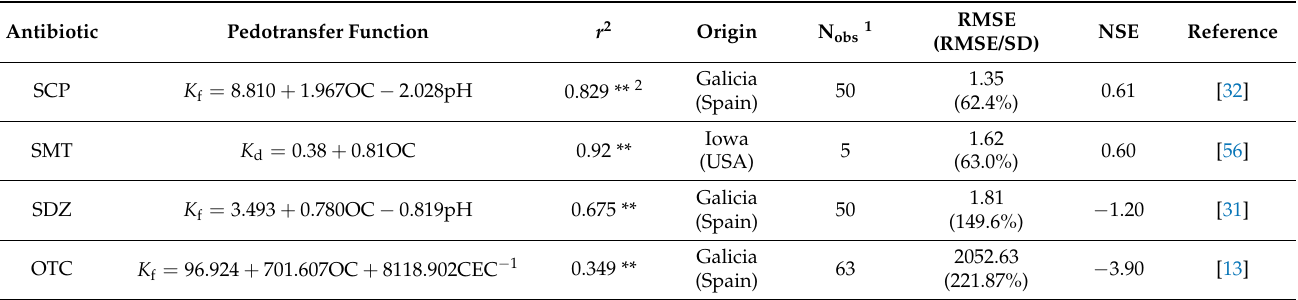
Table 6. Performance of previously published models for sub-datasets “a” and “b”. Antibiotic Pedotransfer